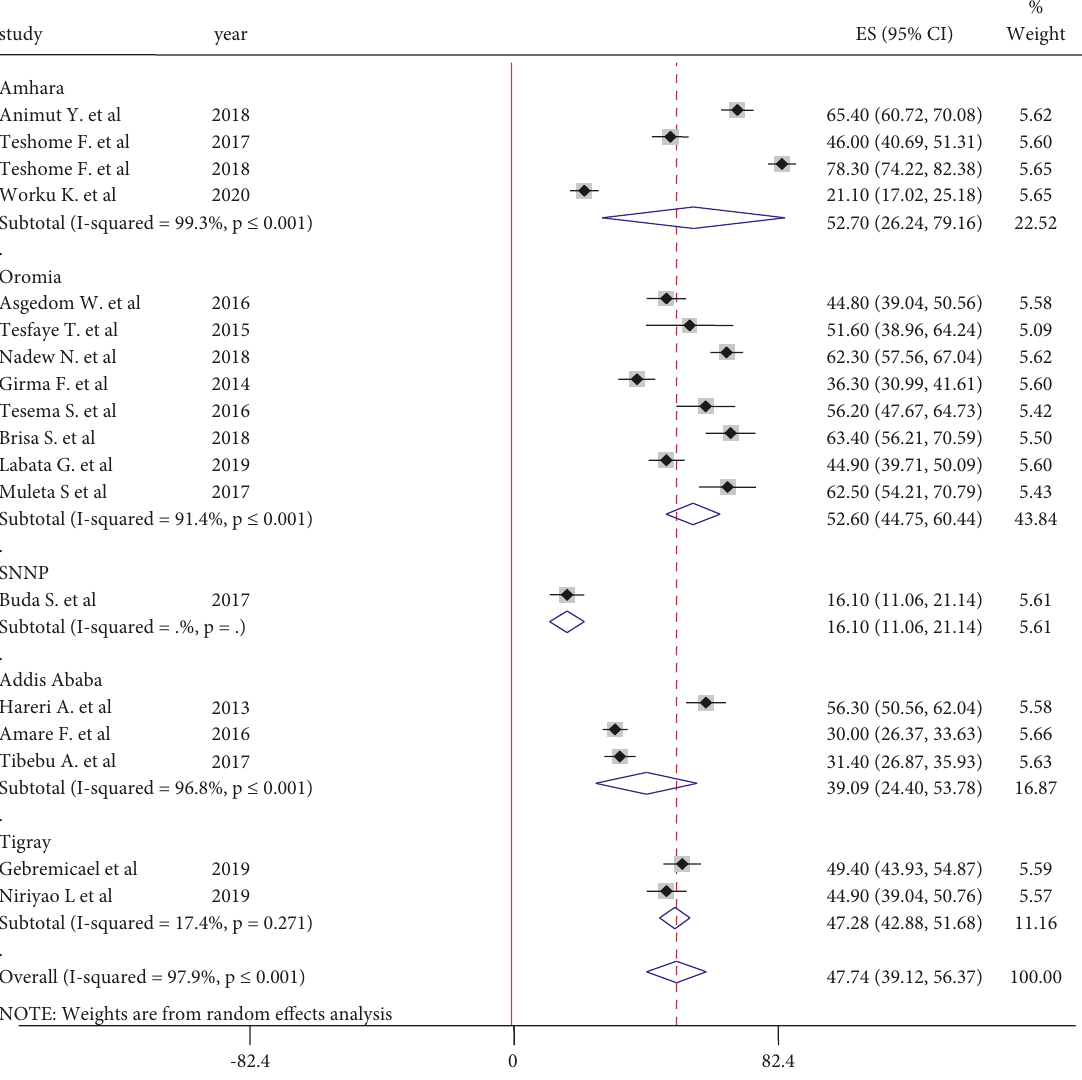
Figure 6: Forest plot on adherence to physical activity among hypertensive patients in